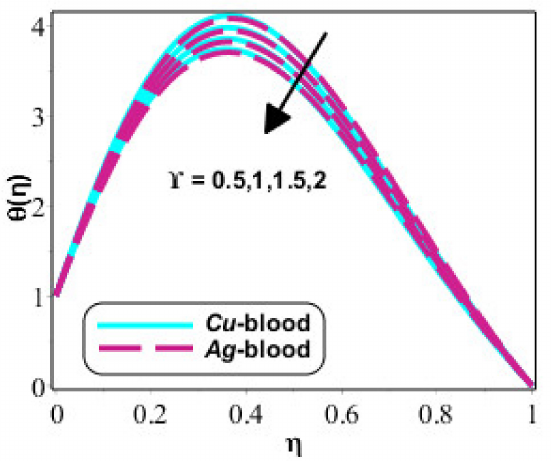
Figure 7. Behaviour of θ ( η ) as varying φ when M = 5, Ec = 2, Nr = 0.5,Pr = 3.9, Y = 0.8, β i = β e = 0.7.